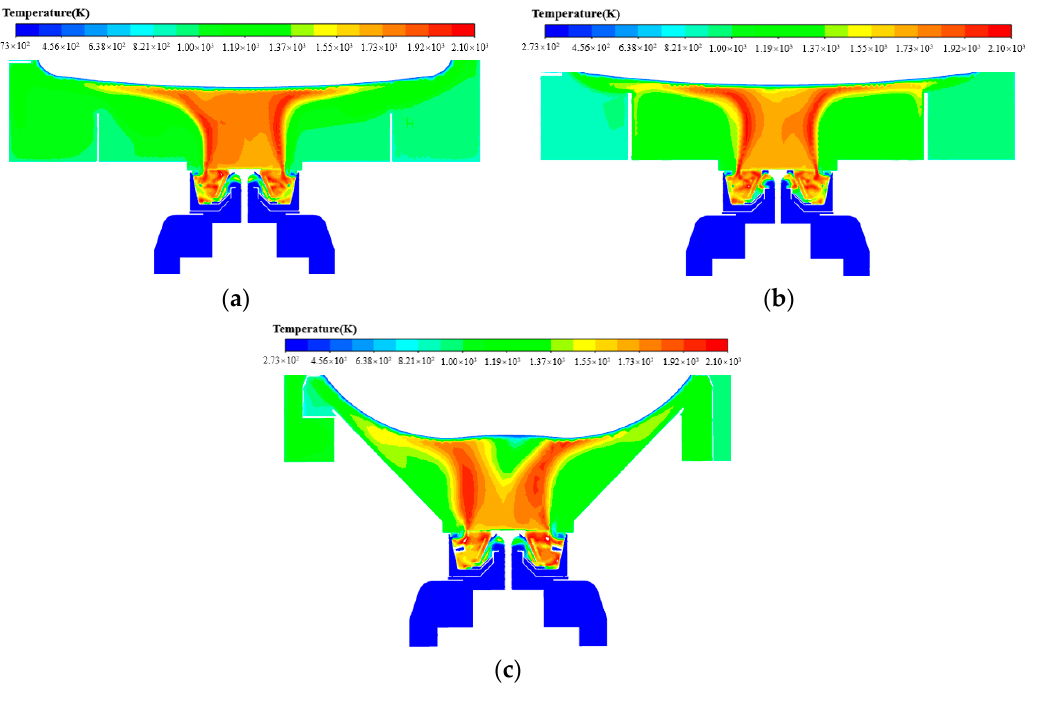
Figure 7. Temperature contours in the central section of the three stoves at 40 kW: ( a ) staple food stove A; ( b ) staple food stove B; ( c ) subsidiary food stove C.